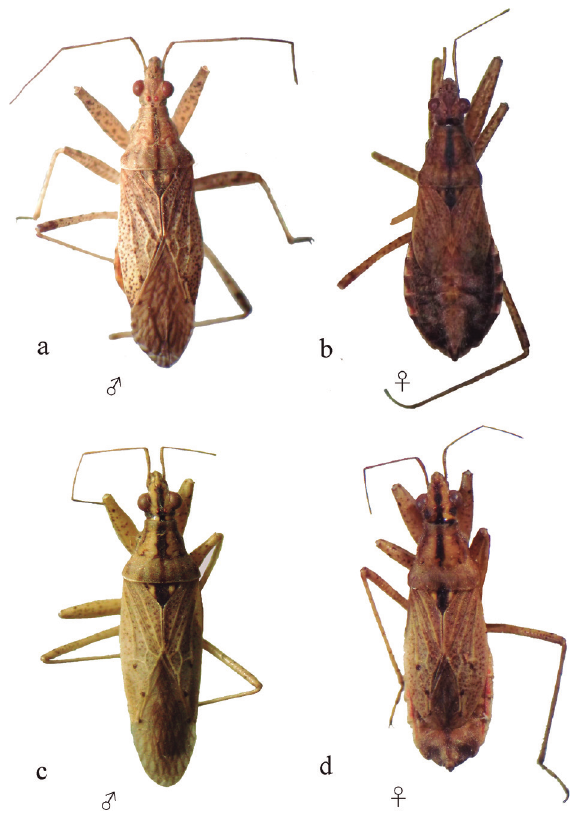
Figure 2. Dorsal view. a-b, Nabis ( Austronabis ) paranensis . c-d, N . ( A .) punctipennis